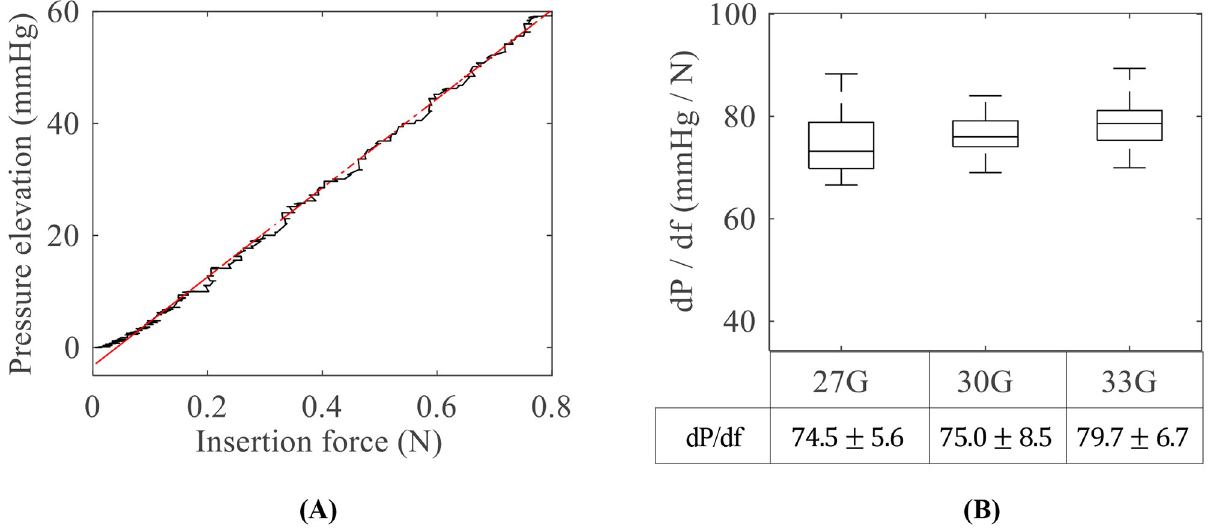
Fig 4. Relationship between pressure and force. A: Linear relationship between pressure elevation and insertion force, and B: slope values according to needle size. Each subgroup contains 30 samples.